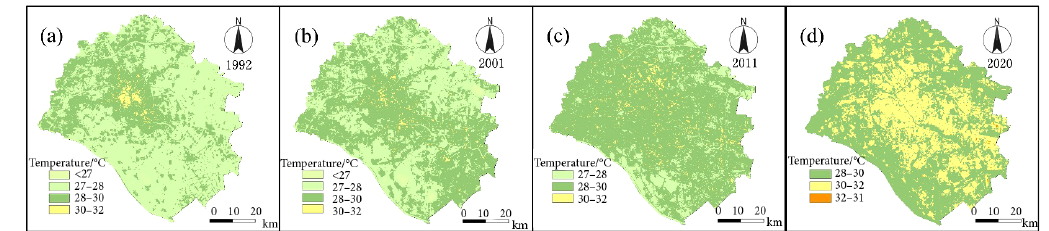
Figure 4. Level distribution of UHI’s influence on high temperature from 1992 to 2020: a) represent 1992; b) represent 2001; c) represent 2011; d) represent